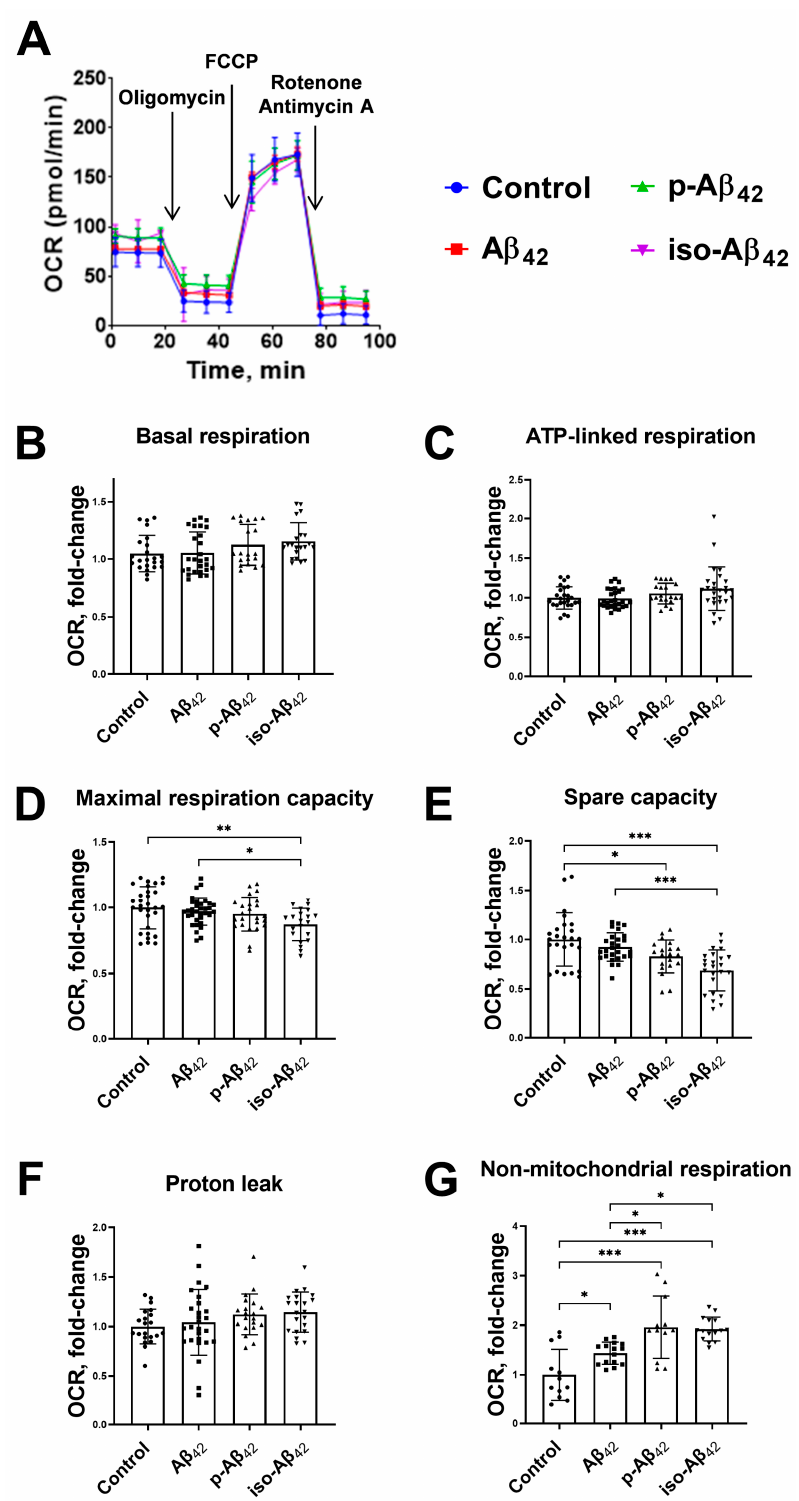
Figure 6. The effects of beta-amyloid isoforms on the bioenergetic functions of bEnd.3 cells after 4 h incubation. Cells were incubated with 10 µ M of A β 42 , p-A β 42 and iso-A β 42 . ( A ) Representative raw data of bioenergetic function. ( B ) Basal respiration, ( C ) ATP-linked respiration, ( D ) maximal respiration capacity, ( E ) spare capacity, ( F ) proton leak and ( G ) non-mitochondrial respiration are demonstrated. The results were calculated based on data obtained using bioenergetic functional analysis (for details, see Figure 5). The values in the control samples were taken as 1. All